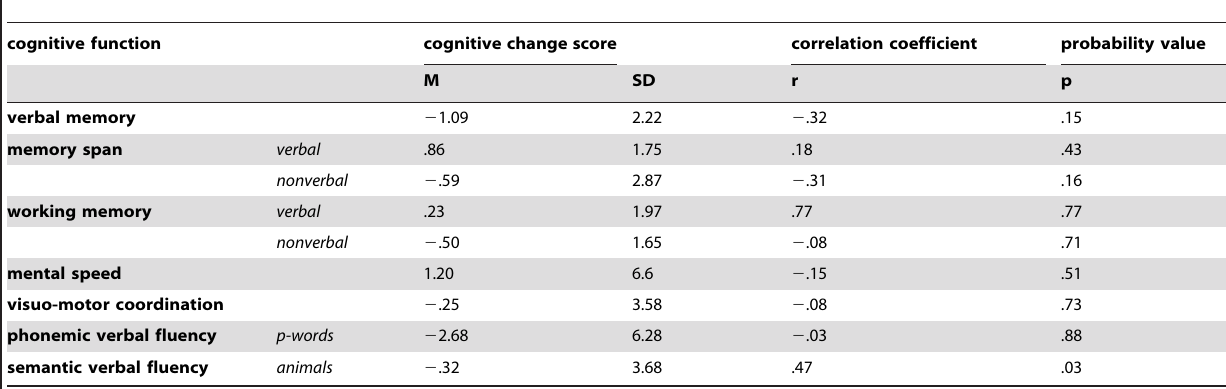
Table 2. Displayed are means and standard deviations of the difference values for all cognitive domains, correlation coefficients and the probability